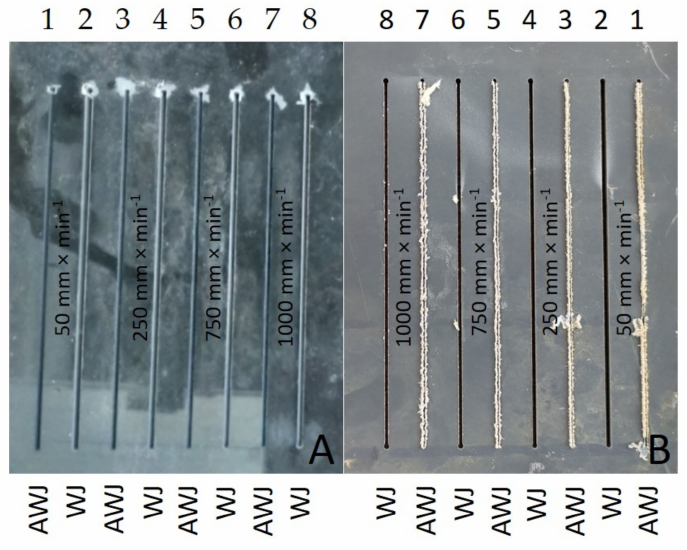
Figure 7. Cutting gaps in PVC-U + MOBIHEL: ( A ) WJ and AWJ inlet; ( B ) WJ and AWJ